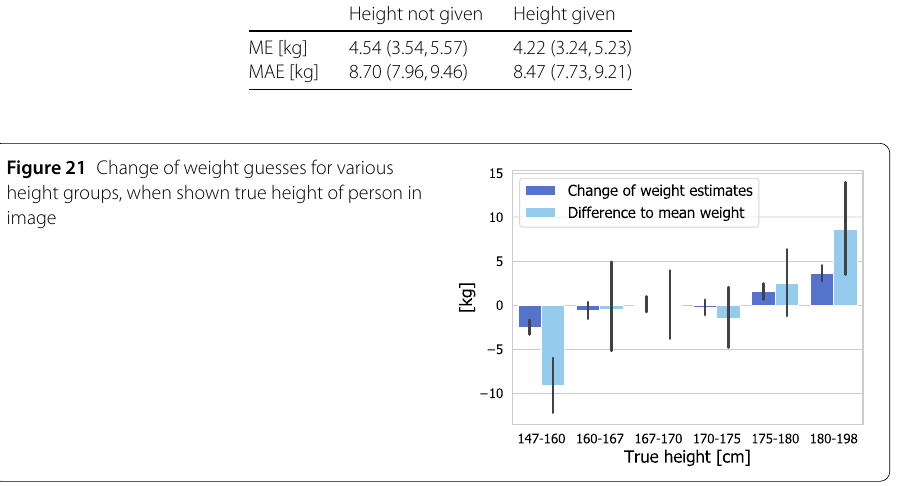
Table 4 Comparison of weight-guessing results when showing vs. not showing true height labels to workers, with bootstrapped 95% confidence intervals (only workers from Europe and